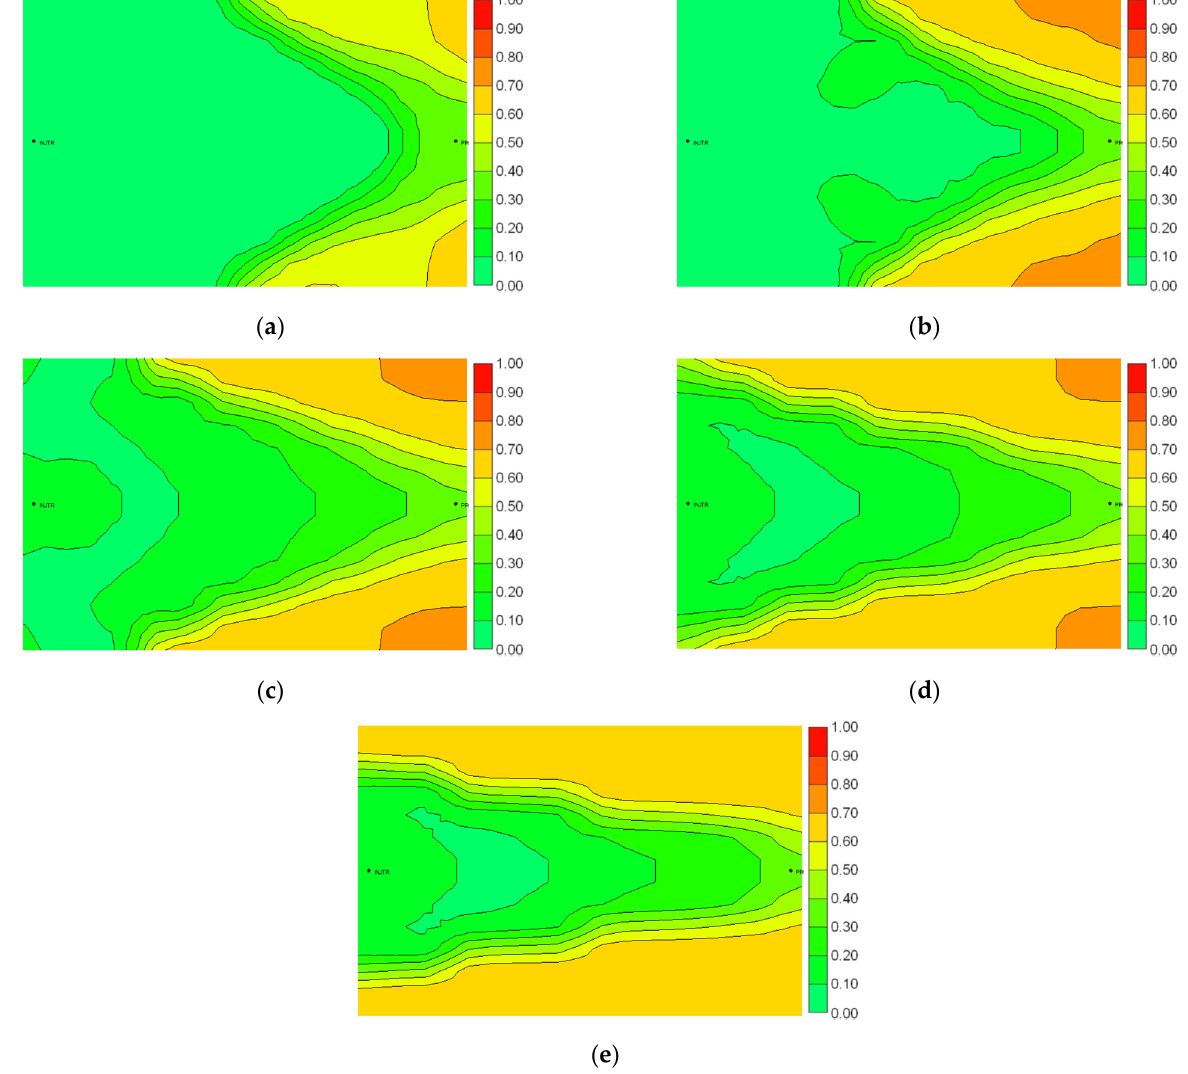
Figure 10. Oil saturation distribution after steam flooding. ( a ) mass fraction of heavy components: 0. ( b ) mass fraction of heavy components: 0.25. ( c ) mass fraction of heavy components: 0.5. ( d ) mass fraction of heavy components: 0.75. ( e ) mass fraction of heavy components: 1.0.